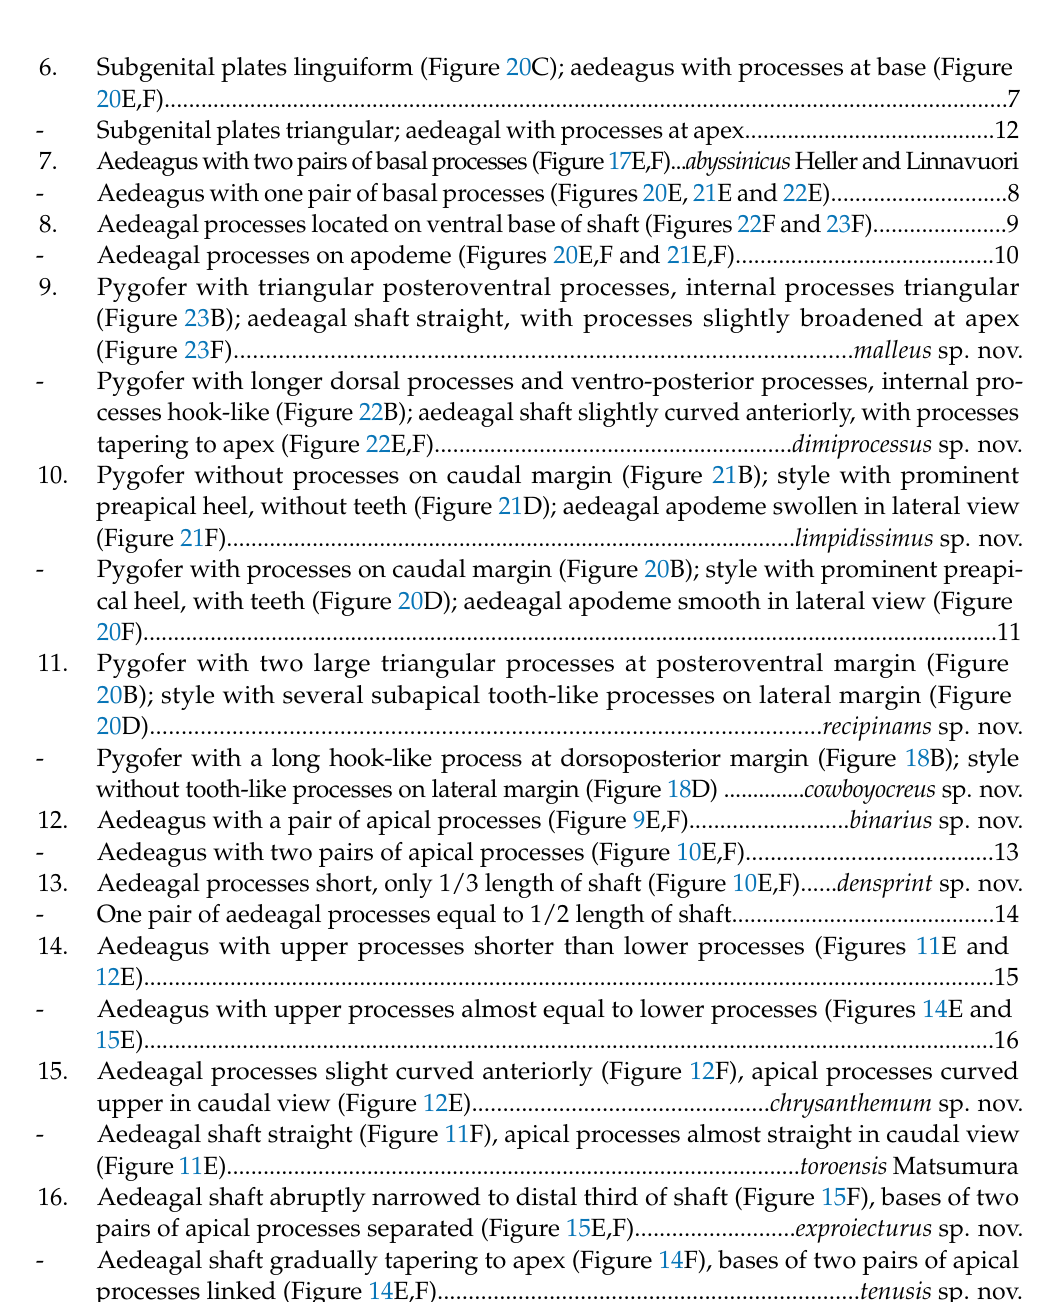
6. Subgenital plates linguiform (Figure 20C); aedeagus with processes at base (Figure 20E,F)..........................................................................................................................................7 - Subgenital plates triangular; aedeagal with processes at apex.........................................12 7. Aedeagus with two pairs of basal processes (Figure 17E,F)... abyssinicus Heller and Linnavuori - Aedeagus with one pair of basal processes (Figures 20E, 21E and 22E).............................8 8. Aedeagal processes located on ventral base of shaft (Figures 22F and 23F)......................9 - Aedeagal processes on apodeme (Figures 20E,F and 21E,F)..........................................10 9. Pygofer with triangular posteroventral processes, internal processes triangular (Figure 23B); aedeagal shaft straight, with processes slightly broadened at apex (Figure 23F)................................................................................................ malleus sp. nov. - Pygofer with longer dorsal processes and ventro-posterior processes, internal pro- cesses hook-like (Figure 22B); aedeagal shaft slightly curved anteriorly, with processes tapering to apex (Figure 22E,F).......................................................... dimiprocessus sp. nov. 10. Pygofer without processes on caudal margin (Figure 21B); style with prominent preapical heel, without teeth (Figure 21D); aedeagal apodeme swollen in lateral view (Figure 21F)............................................................................................. limpidissimus sp. nov. Pygofer with processes on caudal margin (Figure 20B); style with prominent preapi- cal heel, with teeth (Figure 20D); aedeagal apodeme smooth in lateral view (Figure 20F)............................................................................................................................................11 11. Pygofer with two large triangular processes at posteroventral margin (Figure 20B); style with several subapical tooth-like processes on lateral margin (Figure